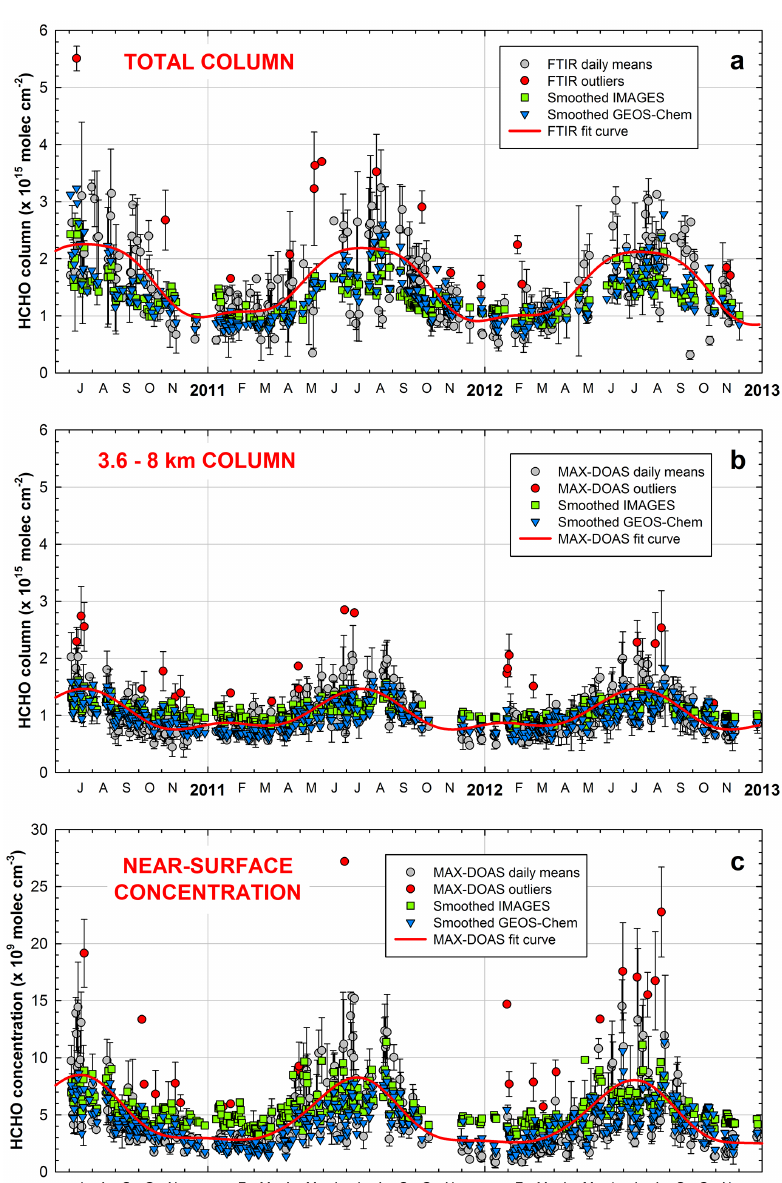
Figure 6. Time series of daily-mean HCHO abundances and the associated 1 σ SD bars from the FTIR ( a ) and MAX-DOAS ( b ) data sets. The solid thick curves (in red) represent the fitting function calculated by applying to the whole time series the statistical bootstrap resampling method from Gardiner et al. (2008). The daily-mean HCHO amounts from the smoothed IMAGES and GEOS-Chem models are displayed in green and blue, respectively. A similar figure, but for the HCHO concentration derived from MAX-DOAS and the CTMs within the 3.6– 3.8km near-surface layer, is drawn in ( c ). The outliers (red dots) correspond to daily observation values with relative anomalies to the curve fit calculated by Gardiner et al. (2008), higher than the 95th percentile value of all relative anomalies of the data